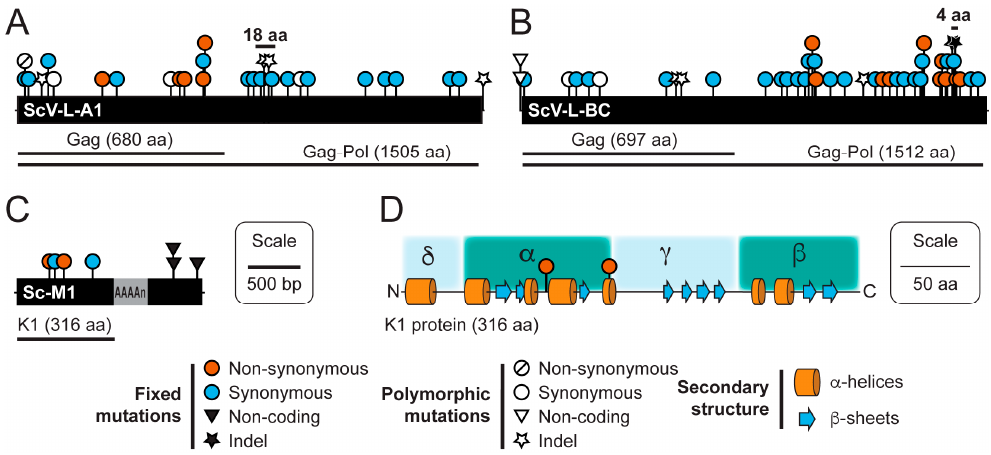
Figure 4. Natural variation in dsRNAs isolated from S. cerevisiae detected by NGS. A linear representation of the three dsRNAs isolated from the strain BJH001 showing the position of ORFs, relative to observed mutations ( A ) ScV-L-A1; 4575 bp, ( B ) ScV-L-BC; 4633 bp, and ( C ) ScV-M1; ~1700 bp. Bars above the indels represent the indel pairs that result in frameshifts of 18 and 4 amino acids in the Gag-Pol fusion protein. ( D ) Secondary structure prediction of the K1 killer toxin showing the position of the non-synonymous mutations in the strain BJH001. Table 2. Polymorphic sites in endogenous dsRNA virus genomes from a clonal isolate of the S. cerevisiae strain